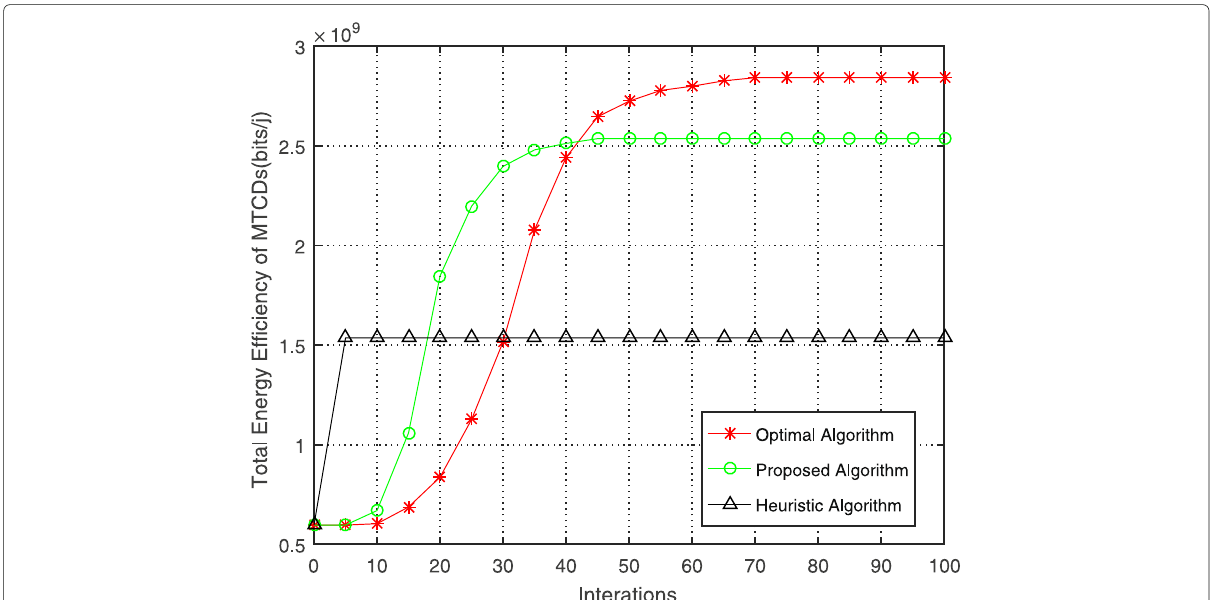
Fig. 4 Convergence behavior of the three algorithms. The MTCDs are uniformly distributed in 100-m radius of the MTCG, and the MTCG is uniformly distributed in 1000-m radius of the BS. The payload of each MTCD is 1500 bit/TTI, and the self-interference of MTCG is (cid:3) = 1